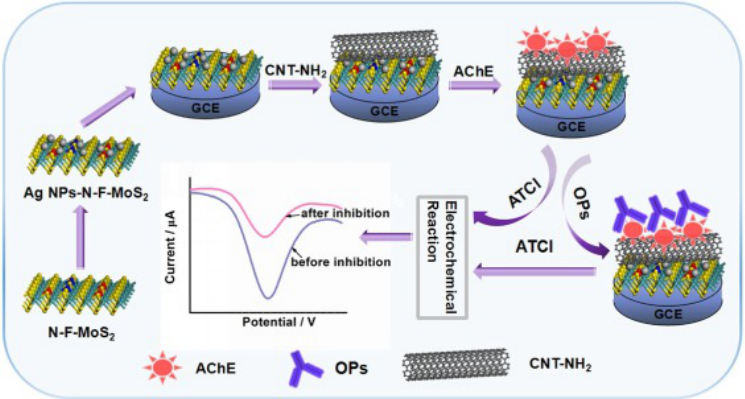
Figure 11. Schematic explaining the steps of fabrication of the pesticide sensor. Reprinted with permission from Ref. [120].